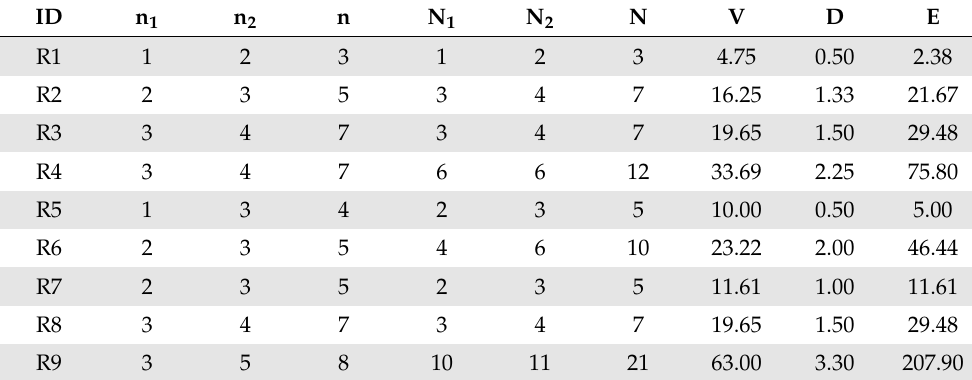
Table A8. Metrics calculations for DMQL .